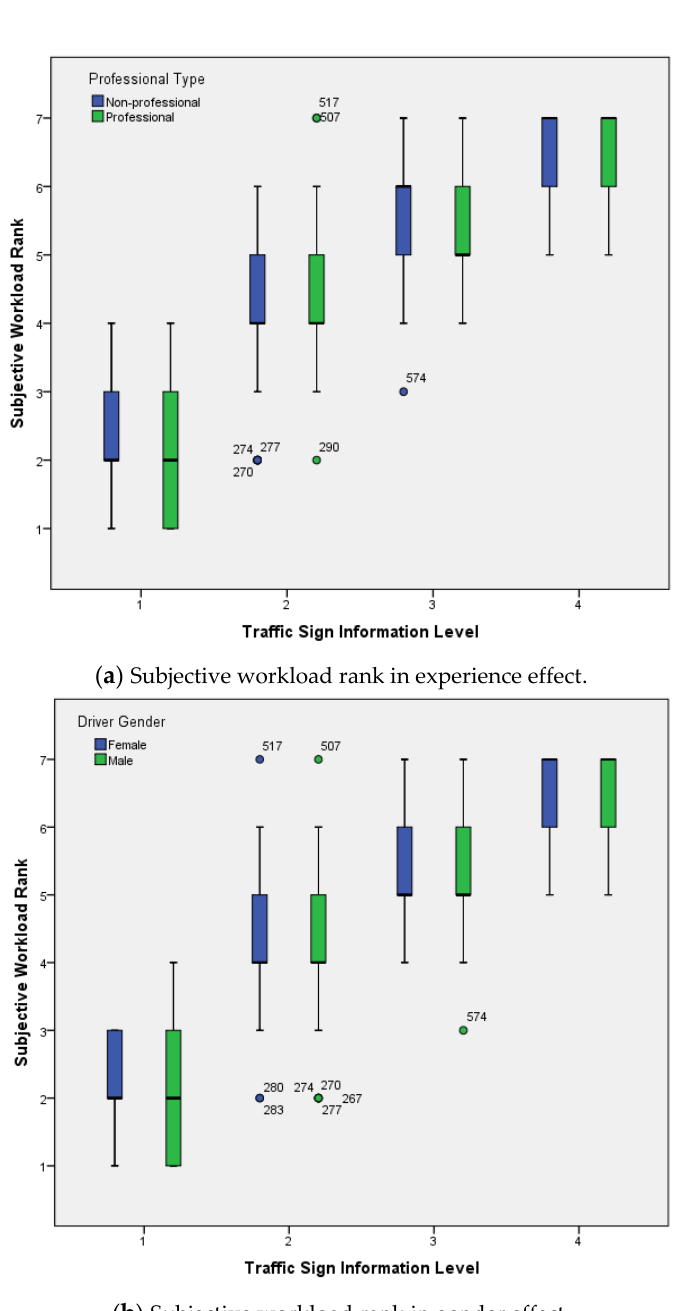
Figure 5. Subjective cognitive workload rank under different information levels.